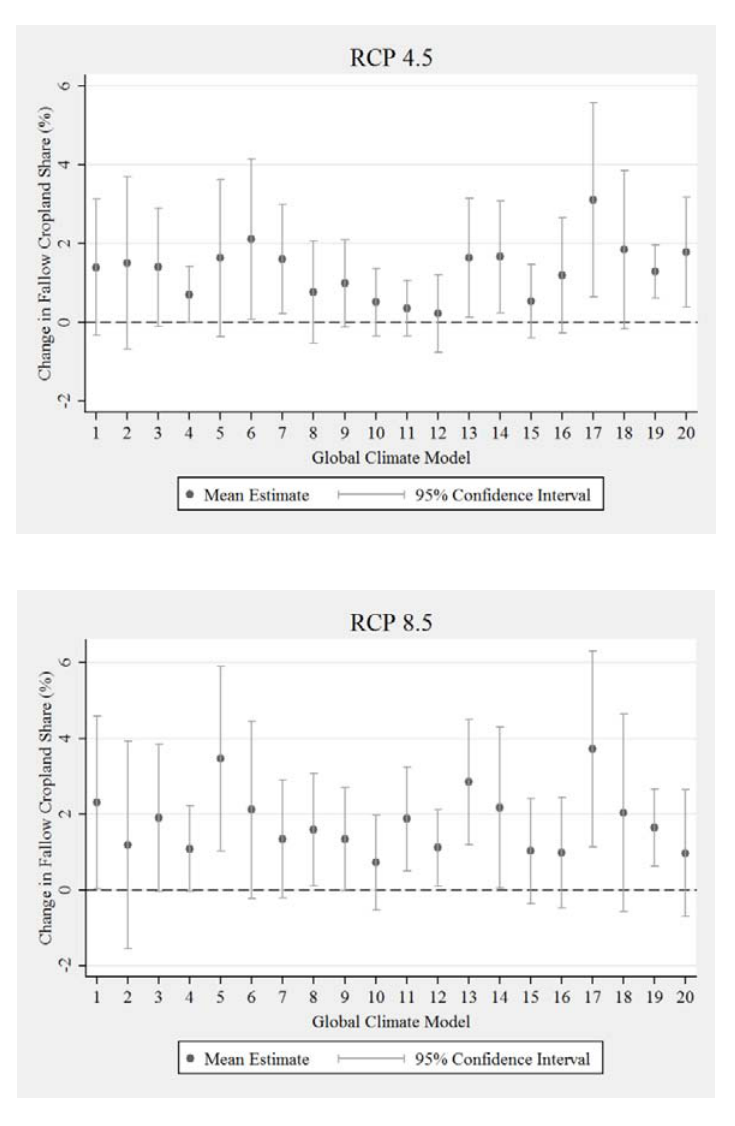
Figure 2. Projected change in fallow share for wheat farms in the PNW region by 2050 (Unit: %).